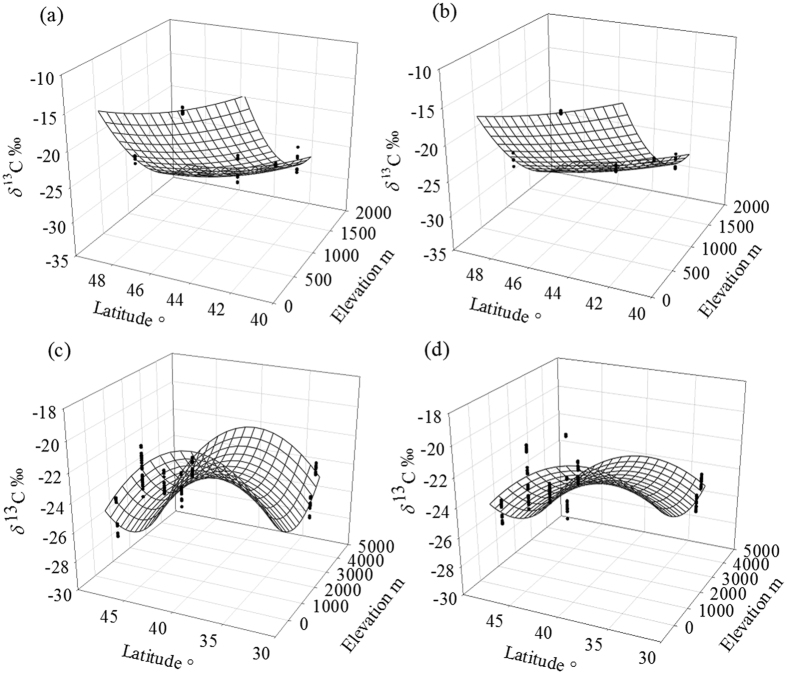
The multiple regression of δ13Croot (at low elevation) and δ13Csoil (at all elevations) with latitude and elevation.Panel (a) shows the regression of δ13Croot (at low elevation <2000m) in NG grasslands (R2 = 0.972 p < 0.0001 n = 45), while panel (b) shows the δ13Croot regression in OG grasslands (R2 = 0.993 p < 0.0001 n = 45). Panel (c) shows the δ13Csoil regression at all elevations (0~5000m) regression in NG grasslands (R2 = 0.810 p < 0.0001 n = 188), while panel (d) shows the δ13Csoil regression in OG grasslands at all elevations (R2 = 0.576 p < 0.0001 n = 188).